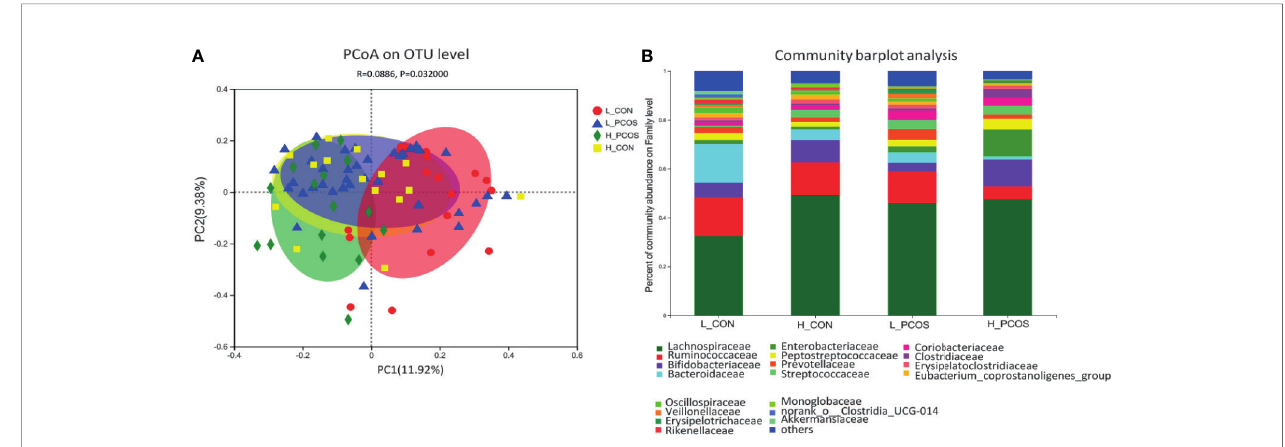
FIGURE 3 | Principal coordinate analysis and Community barplot analysis of the gut microbial communities. (A) Principal coordinate analysis (PCoA) of gut microbiota was based on Bray – Curtis faith distance (ANOSIM, P = 0.032, R = 0.0886 ). Each point represents the bacterial community composition of a single fecal sample, and the axis title represents the percentage change of interpretation (11.92% for PC1 and 9.38% for PC2). (B) Community barplot analysis at Family level in each